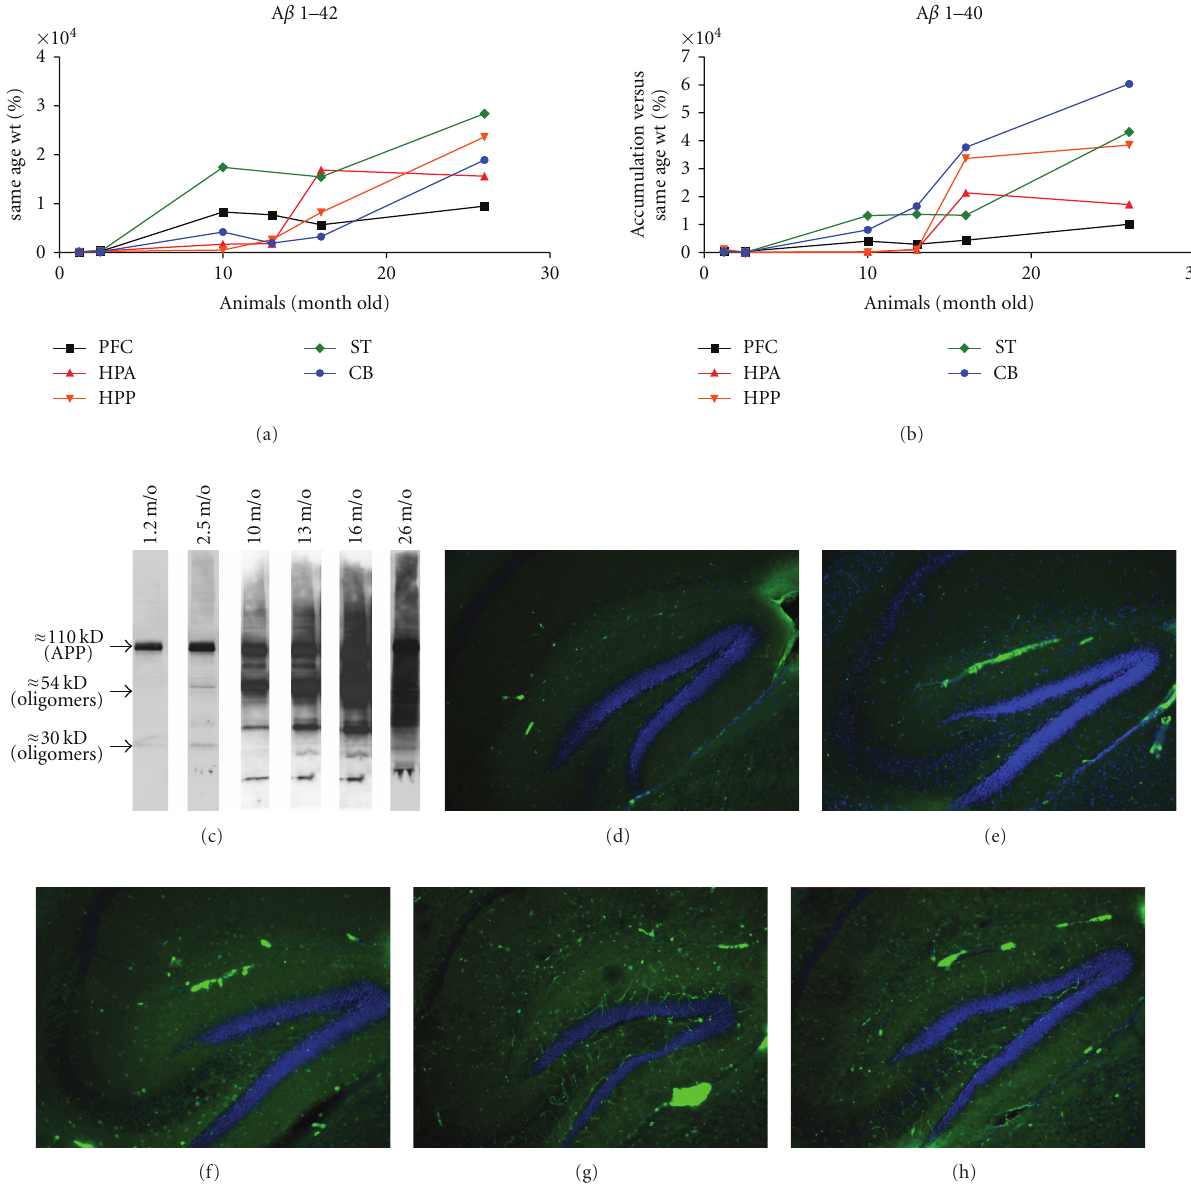
Figure 3: β -Amyloid peptide accumulates with aging in Tg-19959 APP transgenic mice. The level of soluble A β 1–42 and A β 1–40 amyloid peptides in prefrontal cortex (PFC), hippocampus anterior (HPA), hippocampus posterior (HPP), striatum (ST), and cerebellum (CB) at di ff erent ages, compared to wild type controls were quantified by AlphaLISA. Both A β 1–42 (a) and A β 1–40 (b) were gradually increased as animals aged, in all regions studied. The Western blot of hippocampal samples at di ff erent ages using the 48G antibody shows an increase over time in specific aggregation of A β (c). Immunohistochemistry with the 4G8 antibody against A β at di ff erent ages shows insoluble A β deposits in Tg-19959 hippocampi as early as in 2-month-old animals. (d): 2m/o, (e); 6m/o, (f): 10 m/o, (g): 13m/o, and (h): 26m/o. Green: 4G8. Blue: